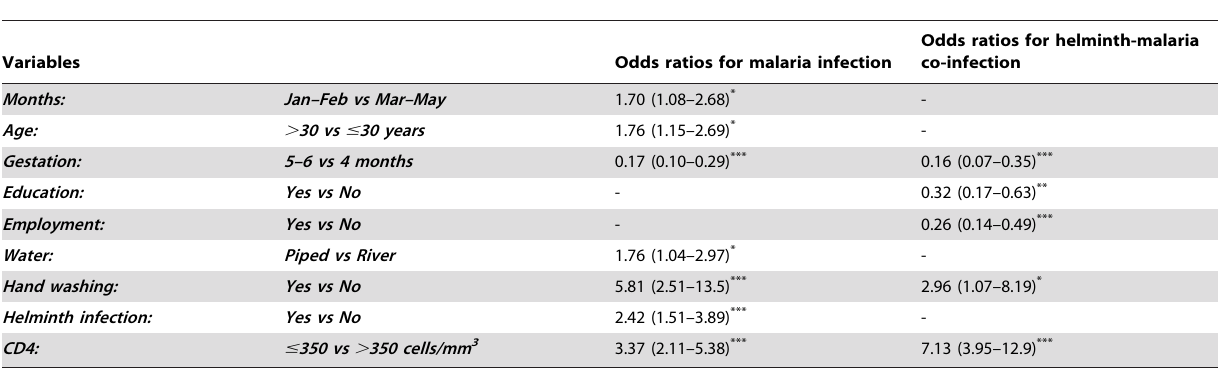
Table 4. Multiple logistic regression analyses to identify risk factors for malaria infection and helminth-malaria co-infection.